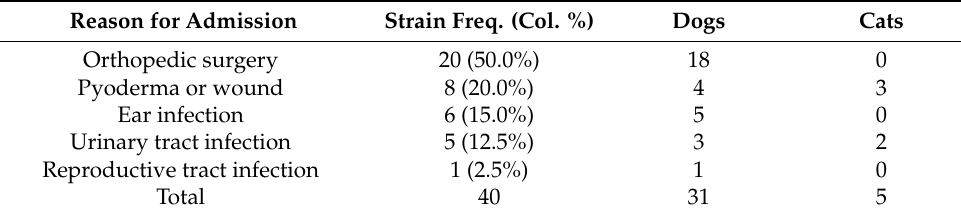
Table 4. Reason for admission at the Veterinary Teaching Hospital of the dogs and cats from whom S. pseudintermedius strains were isolated. Data are reported in decreasing order of